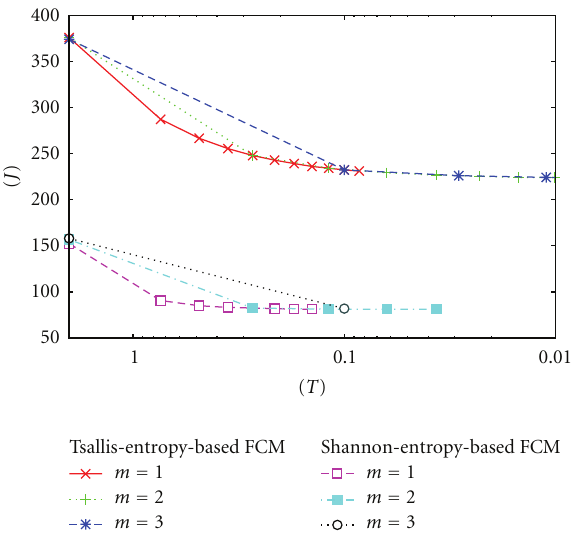
Figure 6: Reduction of the objective values for iris data with decreasing the temperature by VFA. The curves are parameterized by the temperature reduction rate m